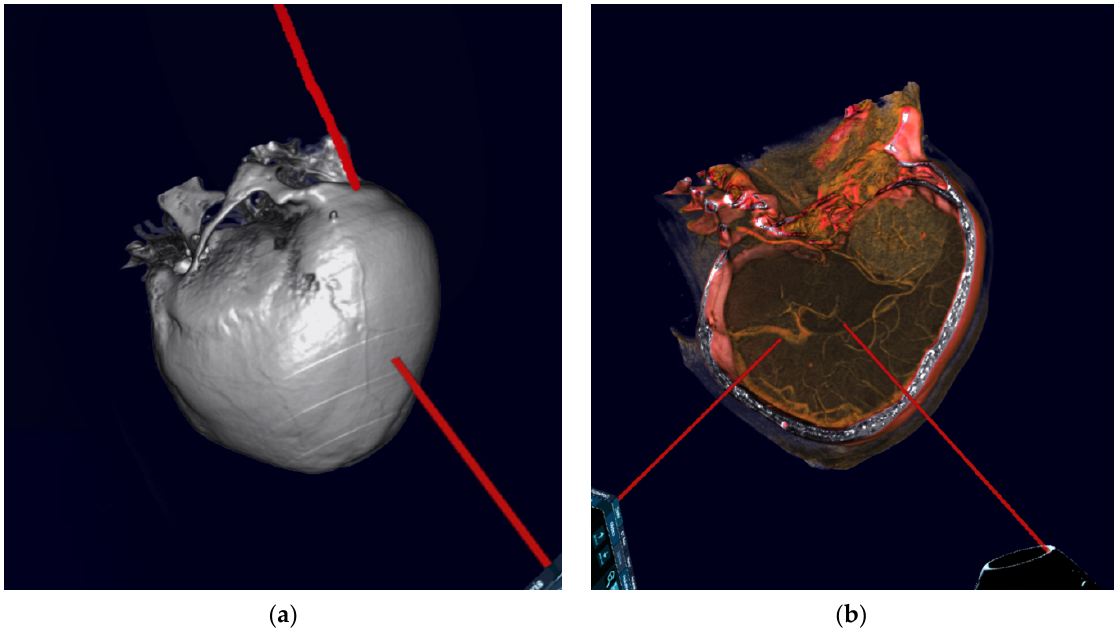
Figure 3. Virtual reality-based head positioning of patient with anterior skull base meningioma. ( a ) Spatial lateral head rotation. ( b ) Representation of the tumor morphology and the anatomical relationships in the same lateral head rotation.